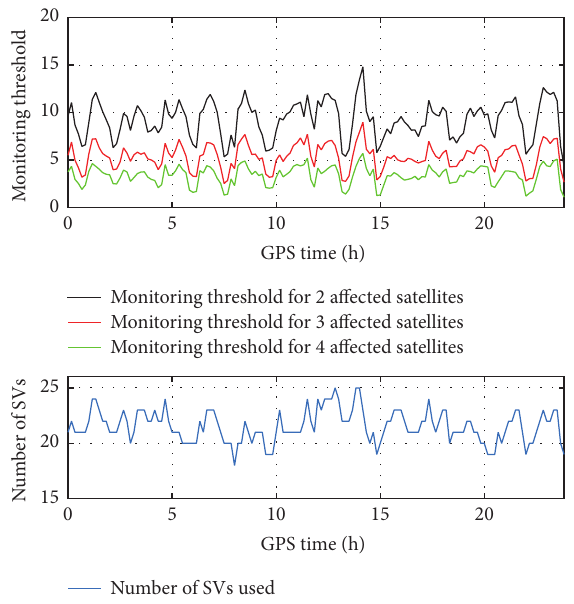
Figure 10: Monitoring threshold for Troll (Antarctica at 72 ∘ South- ern Latitude) as example for a location with less favorable satellite geometry and the effect on the